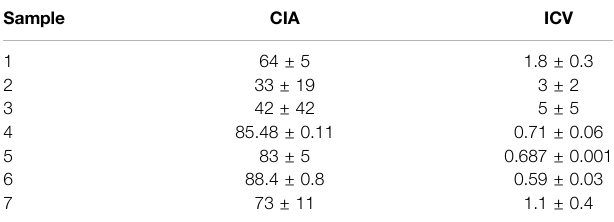
TABLE 3 | Average values of CIA and ICV indices per